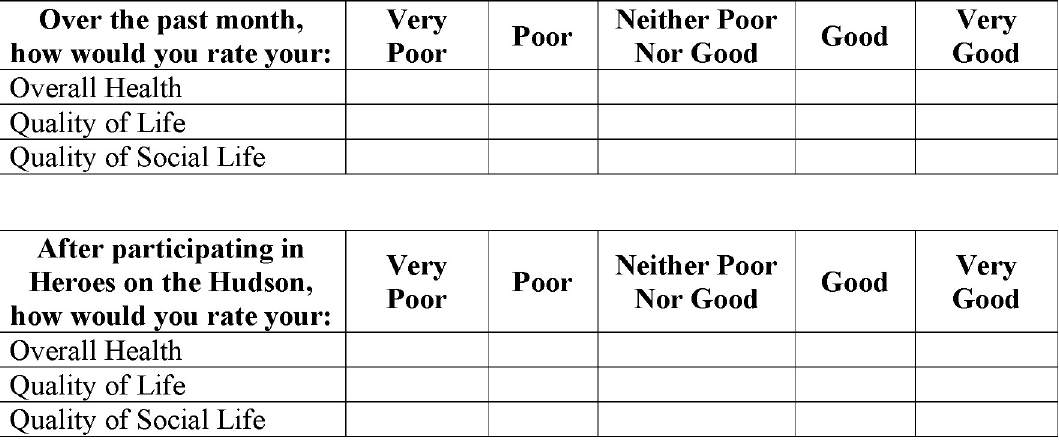
Fig 1. Survey utilized pre- and post-participation in Heroes on the Hudson